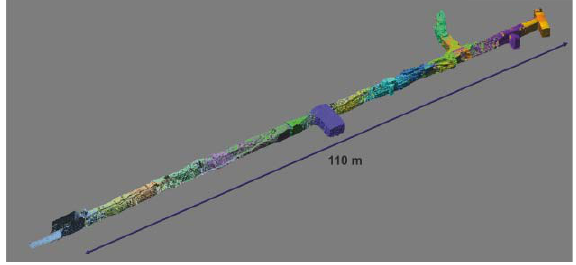
Figure 3. TLS 3D data after the alignment of all the scans.